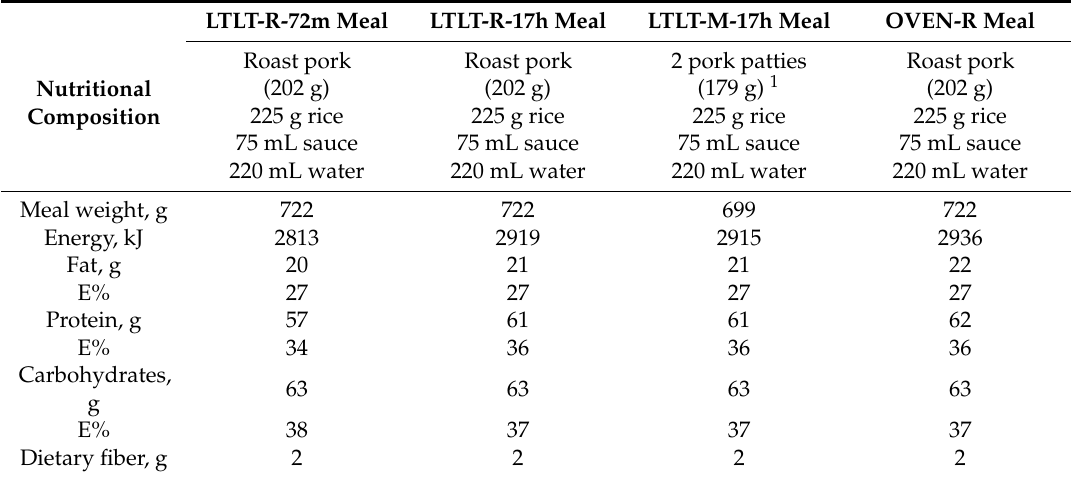
Table 1. Nutritional composition of the four test meals in the meal test